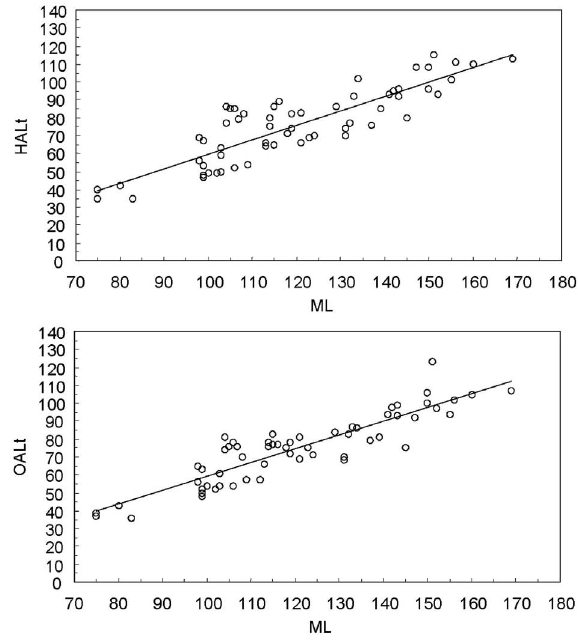
F ig . 3. – Regression lines for HALt and OALt plotted against man- tle length. Measurements in